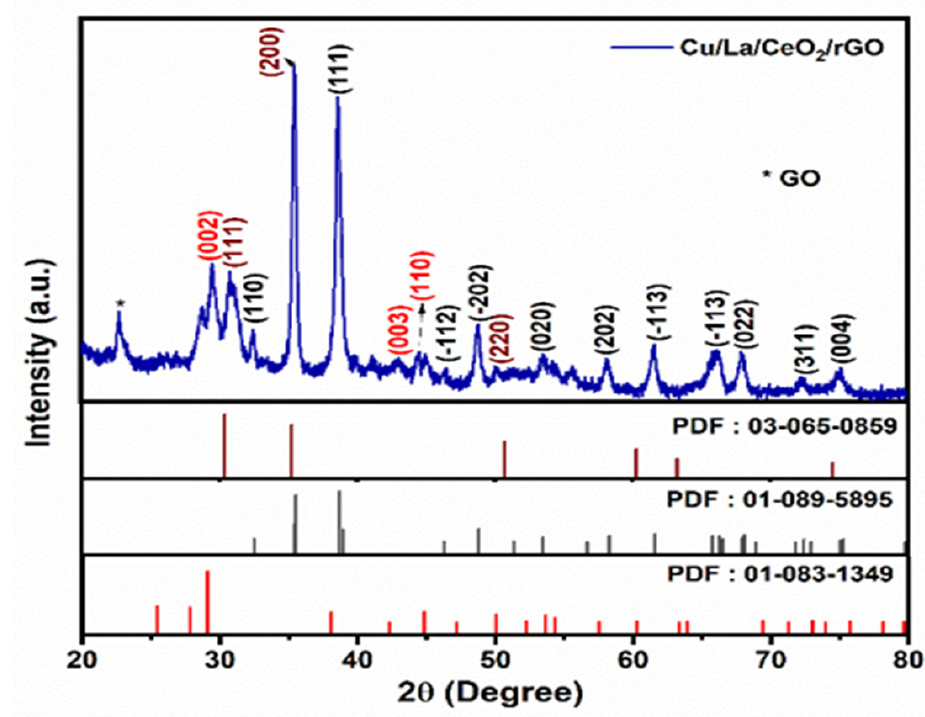
Figure 2. XRD analysis of Cu/La/CeO 2 /GO nanocomposites.